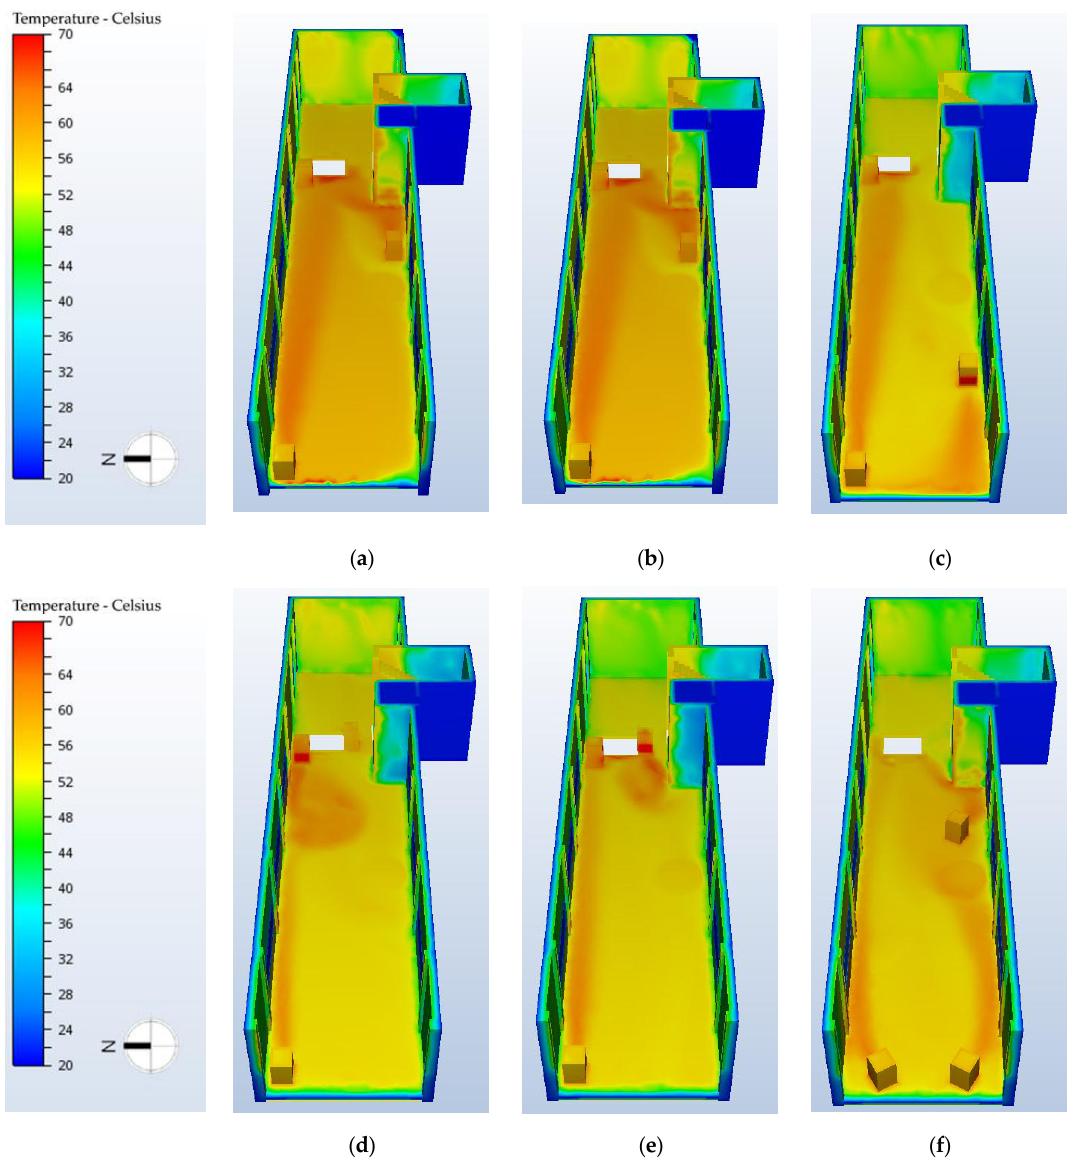
Figure 8. Perspective view (without showing machinery) of the west wall. ( a ) Initial configuration, ( b – f ) case studies where positions/orientations of the fan heaters were changed. Table 4. Simulated average temperatures at the plansifters for the initial configuration (a) and for the case studies including changes in the position/orientation of the fan heaters (b–f).